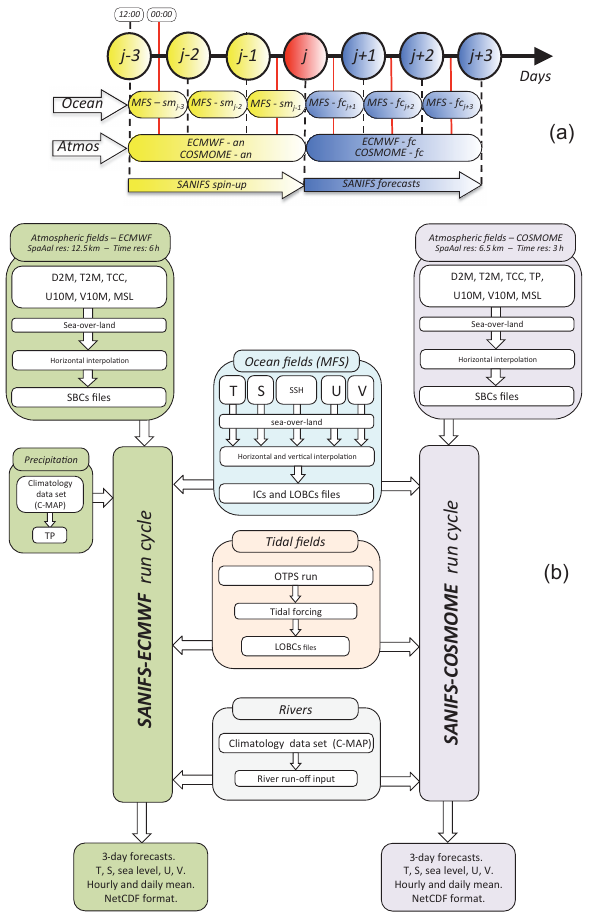
Figure 3. SANIFS daily forecast cycle (a) and operational chain (b)